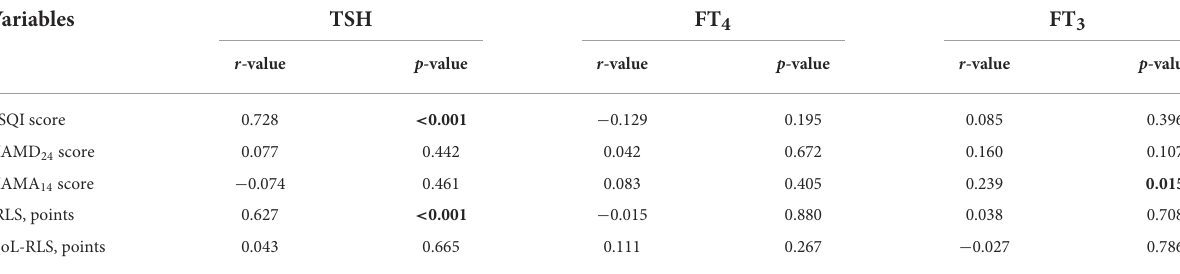
TABLE 4 Correlation between thyroid hormones and clinical characteristics of RLS.